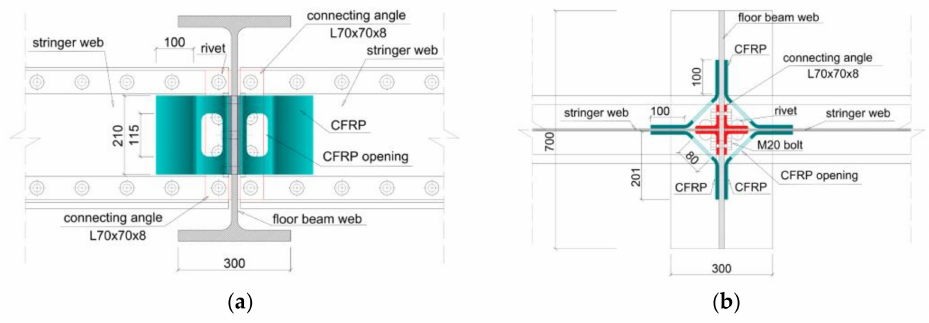
Figure 18. CFRP strengthening system for fatigue-prone detail (all dimensions in mm). ( a ) Lateral view. ( b ) Plan